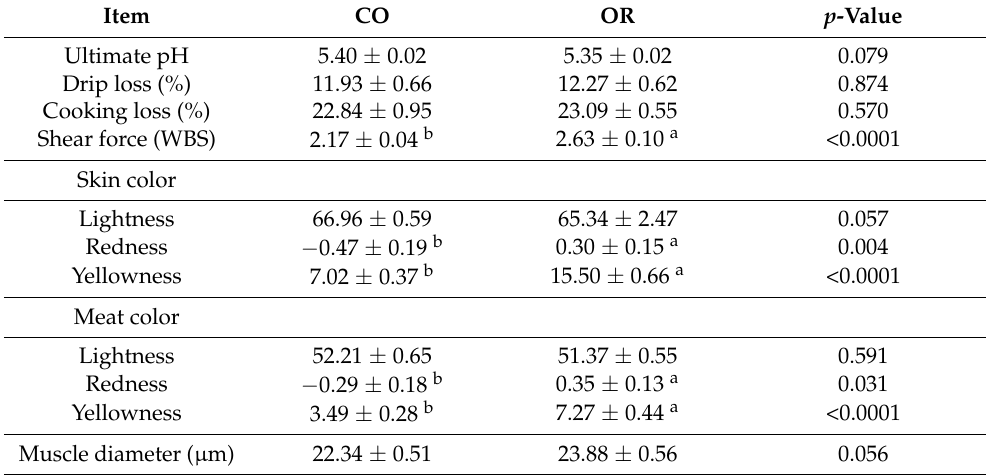
Table 6. Effects of organic raising system on breast meat quality of Korat chicken at 84 d of age (mean ± SD). Item CO OR p -Value Ultimate